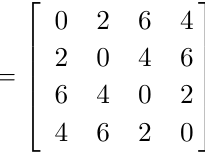
Table 5. { V M } 2 − { V M } 2 two-point correlator values. and in matrix